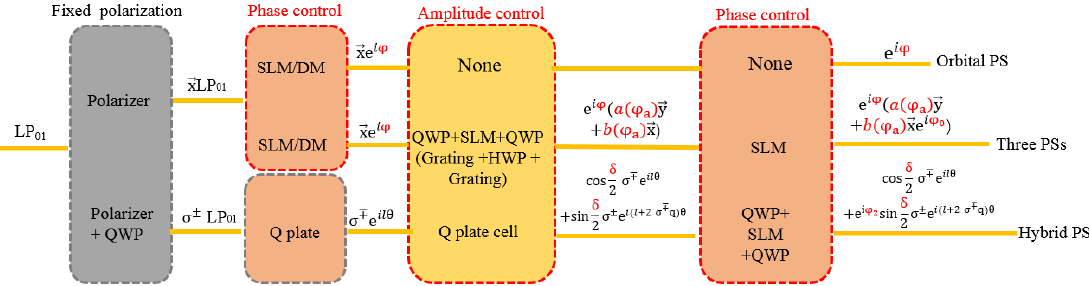
Figure 6. The flow chart of tunable OAM generation by adjusting the phase distributions on the spatial light modulators (SLMs), deformable mirrors (DMs) and q-plate cells.